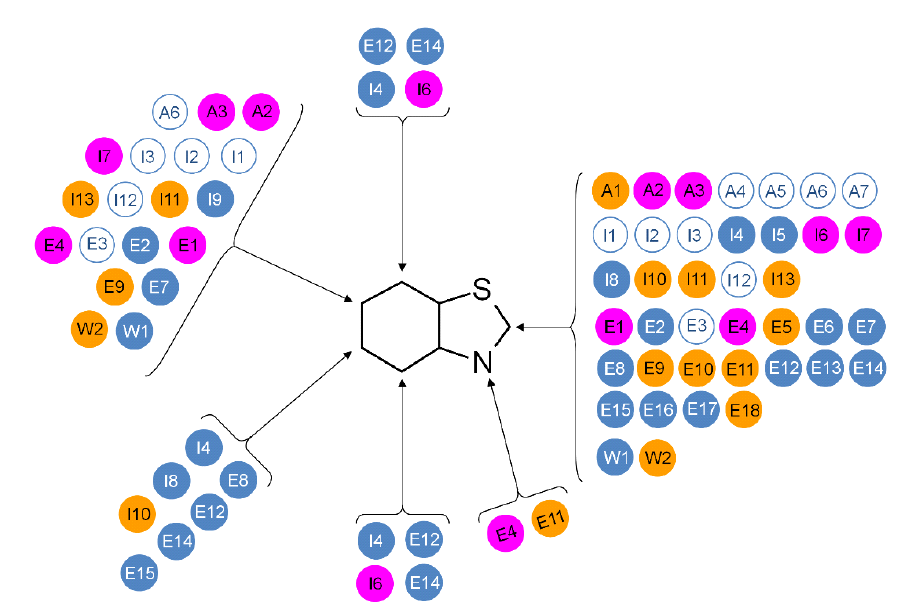
Figure 3. Patterns of substitution displayed by the 1,3-benzothiazole drugs included in DrugBank [3]; A: approved, I: investigational, E: experimental, W: withdrawn; each therapeutic class has been color-coded as follows: yellow = etiotropic agent, magenta = drugs acting on CNS, white = diagnostic, and blue = pharmacodynamic agent (see text for details).